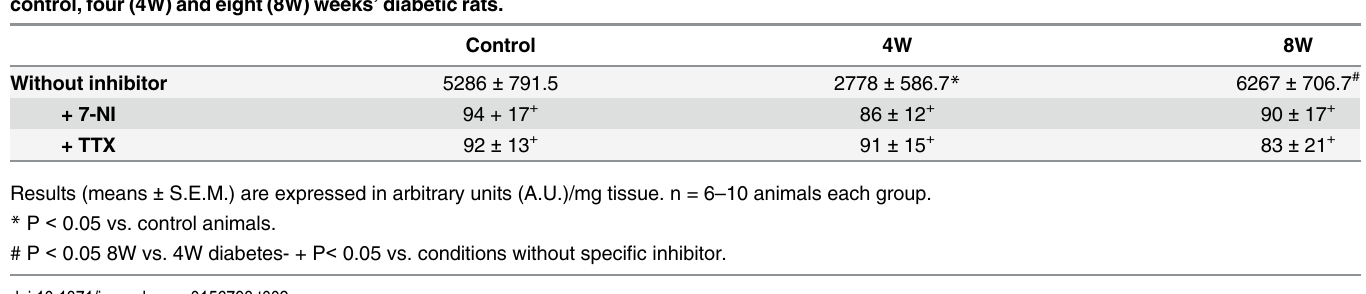
Table 2. Effect of preincubation with 7-nitroindazol (7-NI, 0.1 mmol/L), or 0.1 μ mol/L TTX on EFS-induced NO release in mesenteric segments from control, four (4W) and eight (8W) weeks ’ diabetic rats.